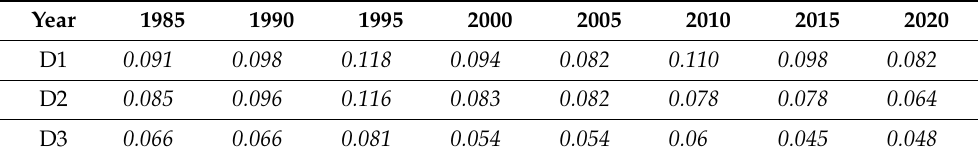
Table 7. The OOBE of RF models in each sampling